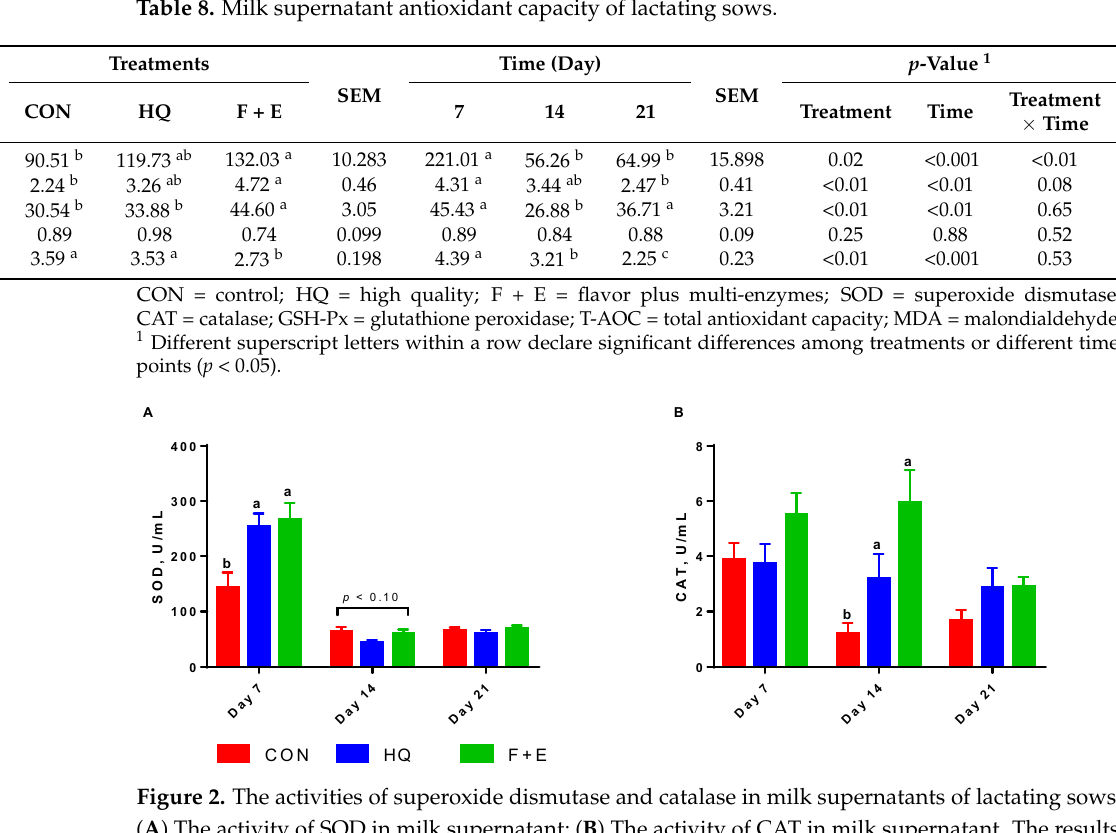
Table 8. Milk supernatant antioxidant capacity of lactating sows.